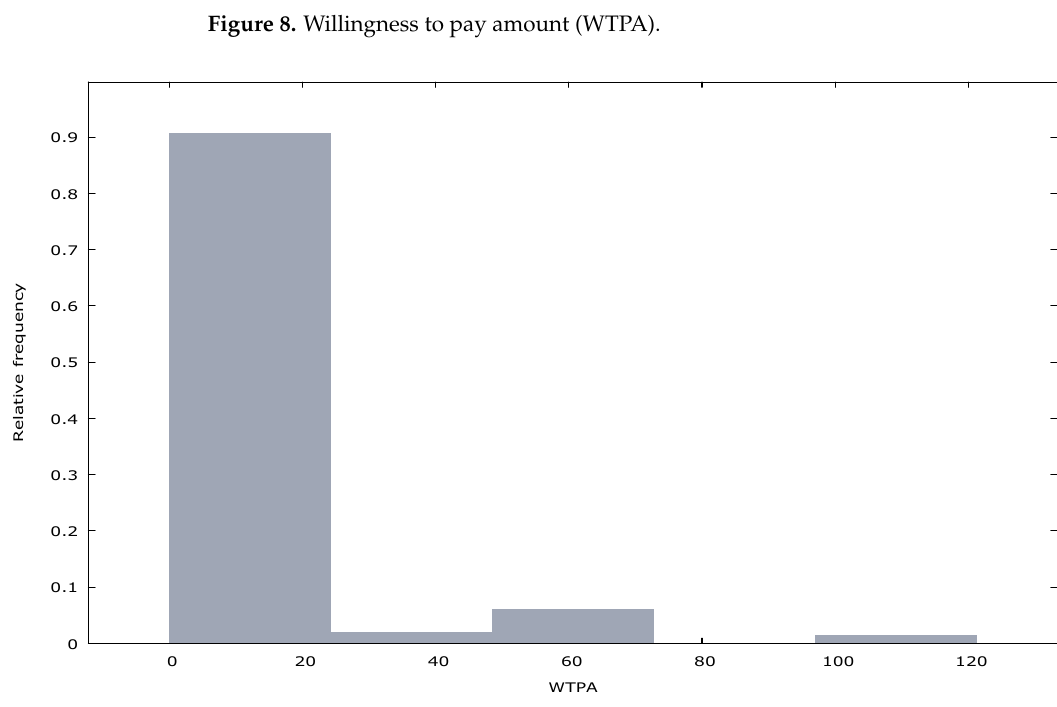
Figure 9. Willingness to pay amount (WTPA) frequency.